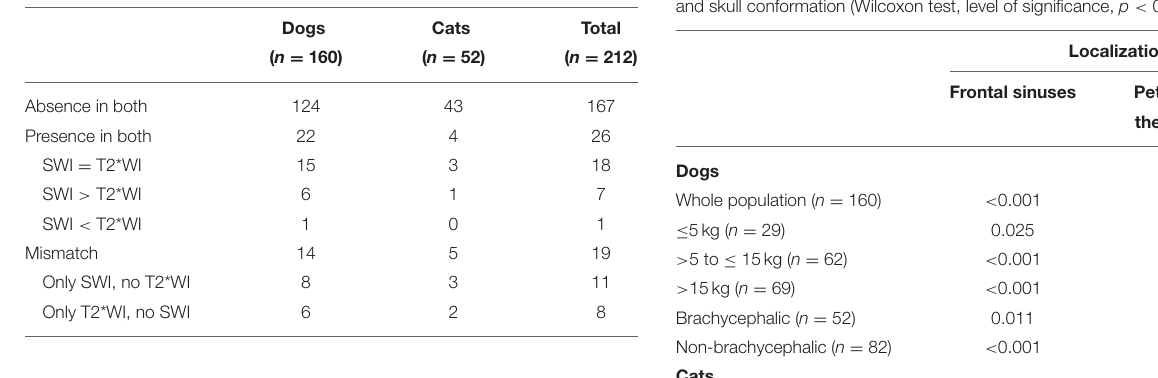
TABLE 1 | Classification of the number of animals according to the presence and/or absence of areas of signal void in susceptibility-weighted imaging (SWI) and T2*-weighted-imaging (T2*WI).